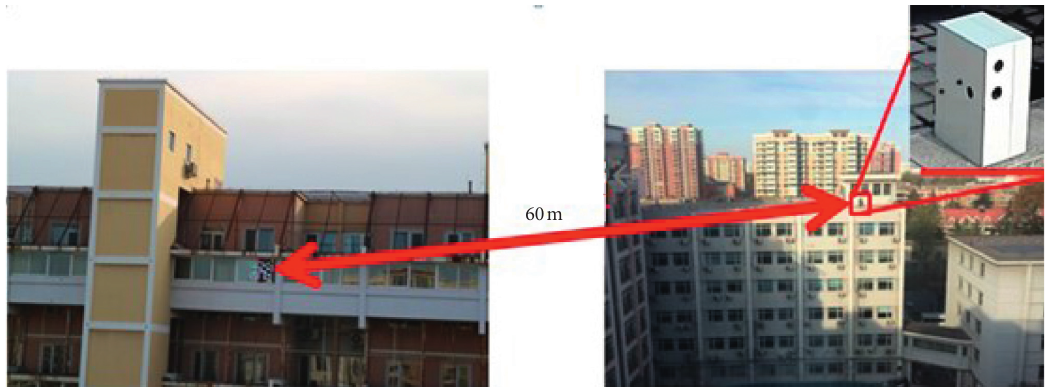
Figure 11: Experimental diagram of the roof of the